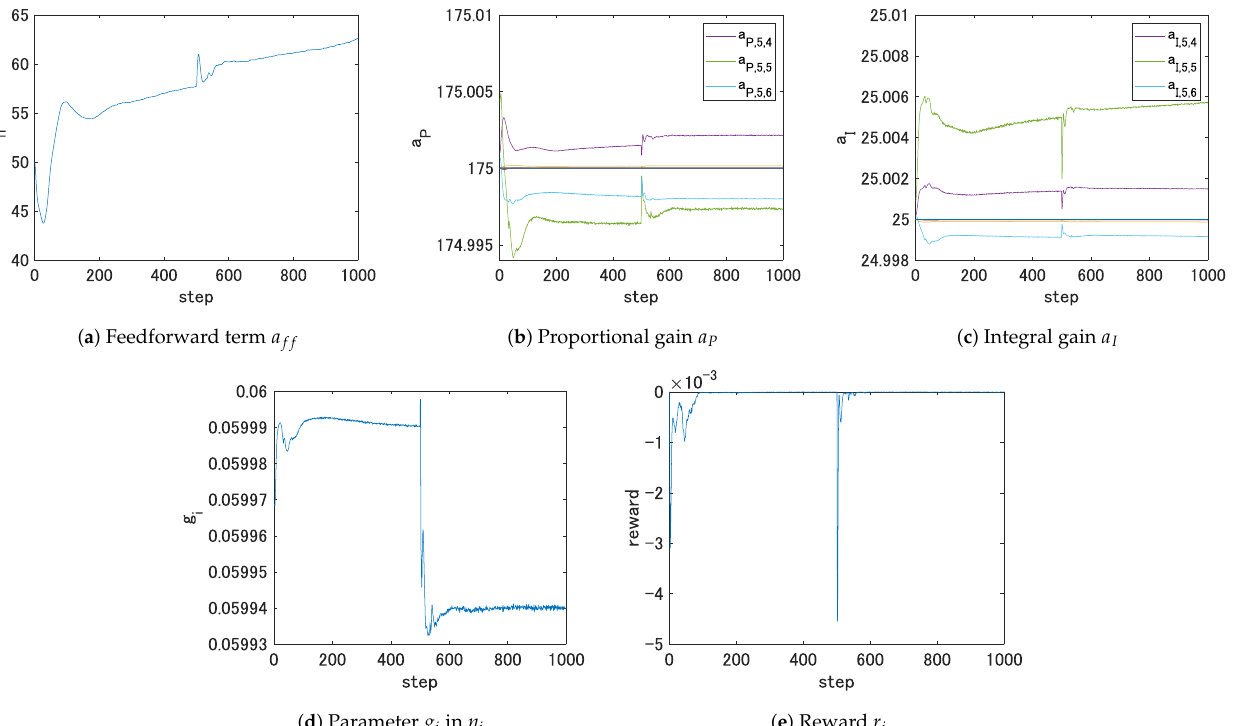
Figure 13. Changes of the quantities of the fifth manipulating device under the reference modification